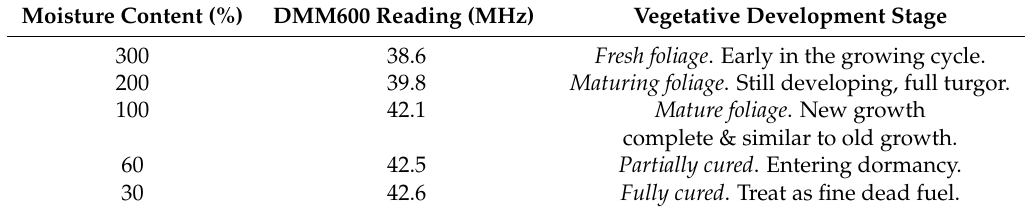
Fully cured . Treat as fine dead